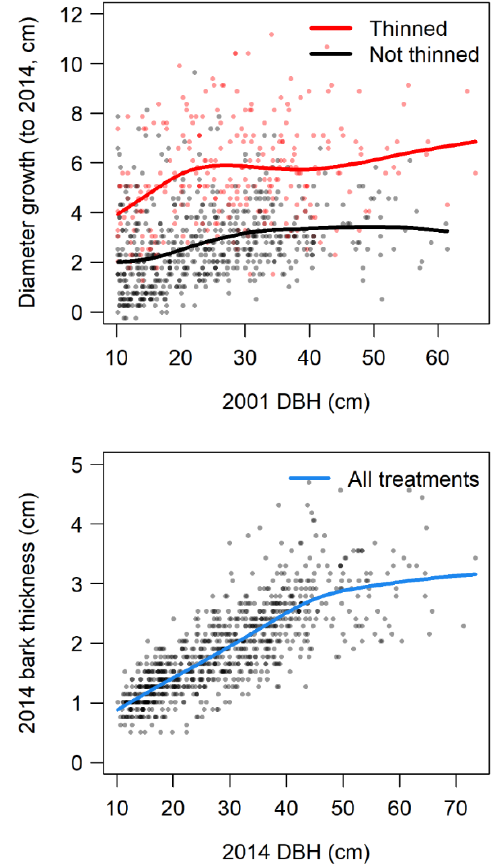
Figure 4. Ponderosa pine periodic dbh growth from 2001 to 2014 by thinning treatment (top panel) and bark thickness by dbh in 2014. Points represent repeat tree measurements, and smooth splines illustrate relationship with tree size.